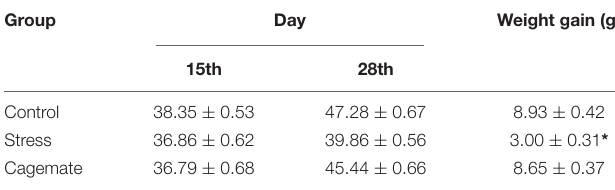
TABLE 3 | Body weight gain during 14 of restraint stress.